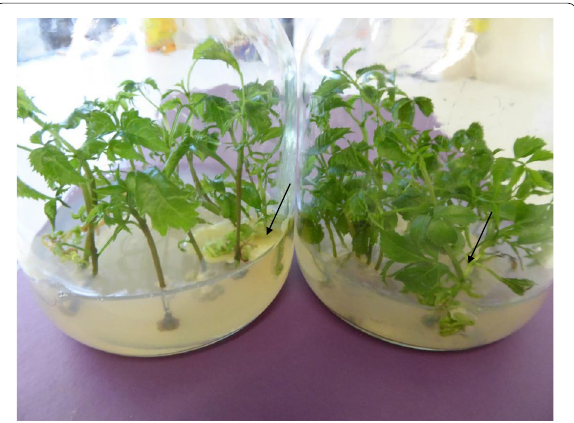
Fig. 1 Contaminated ash shoot-cultures. Proliferating ash shoot cultures contaminated with Bacillus megaterium or possibly B. aryabhattai , which can be seen as a sticky growth on or in the media around the bases of some of the shoots, indicated by